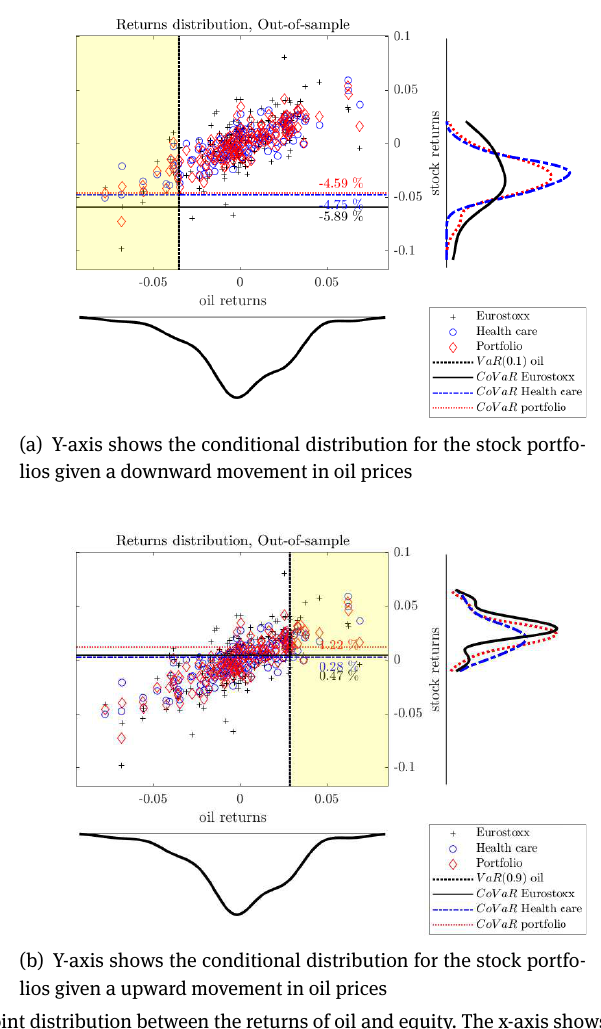
Figure 11: Empirical joint distribution during the out-of-sample period, where the current oil scenario is shaded in yellow